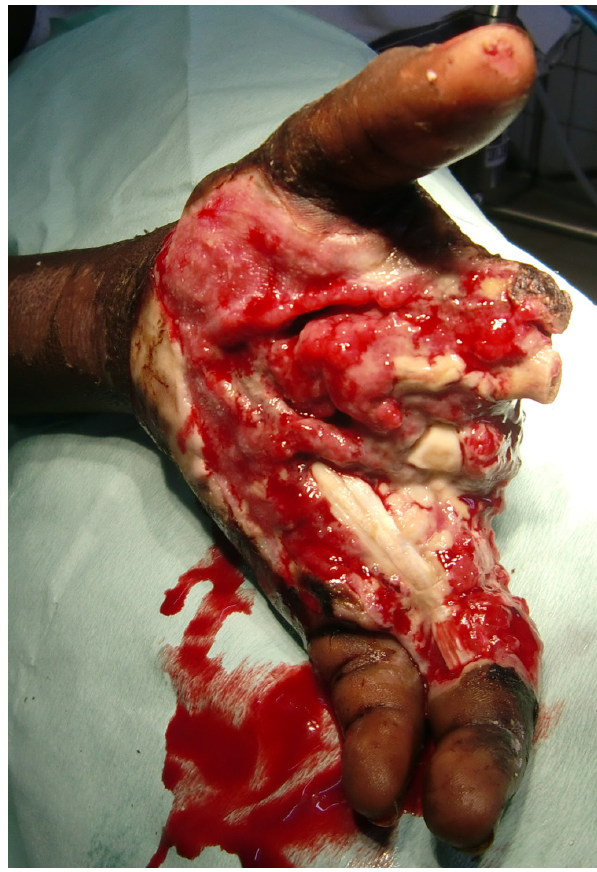
Figure 11. Finger amputation and necrosis, second